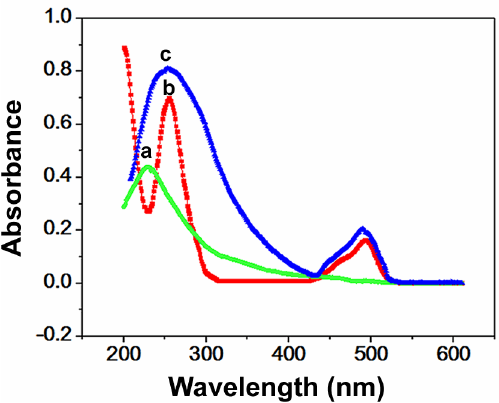
Figure 2. UV-visible absorbance spectra of (a) GO, (b) FAM-W3, and (c) FAM-W3-GO.